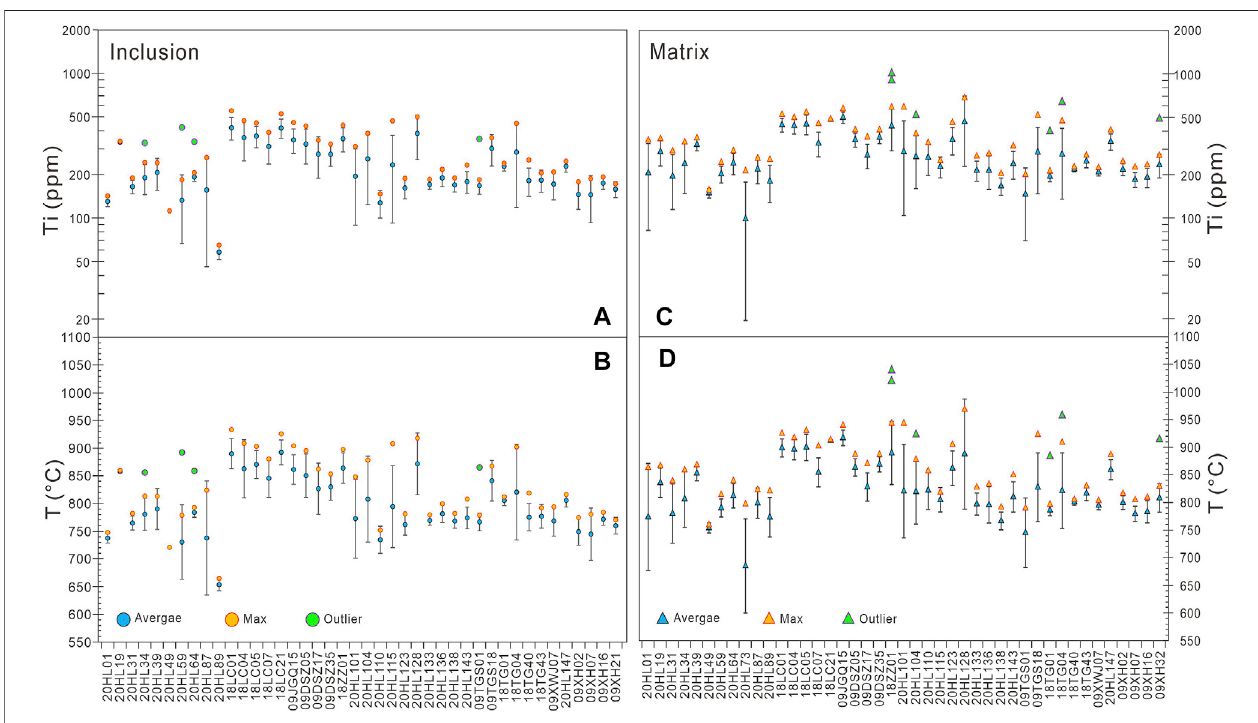
FIGURE4| ThetitaniumconcentrationsofquartzandthecalculatedtemperaturesbyTitaniQthermometerinGrt-Sil-BtandGrt-Btgneisses(orgranulites)fromthe eastern Khondalite Belt. (A,B) The titanium concentrations of quartz inclusions in garnet and the calculated temperatures. (C,D) The titanium concentrations of matrix- type quartz and the calculated temperatures. We have three series of data: the average data, the maximum data and the outlier data. The average concentration of titaniumand thetemperature werecalculatedwithout theoutlierdata.Thetemperatures werecalculatedatpressure=8 kbarand a TiO2 =1.Theerroris1SDofthe dataset in each sample. The TitaniQ model we used here was calibrated by Thomas et al. (2010).